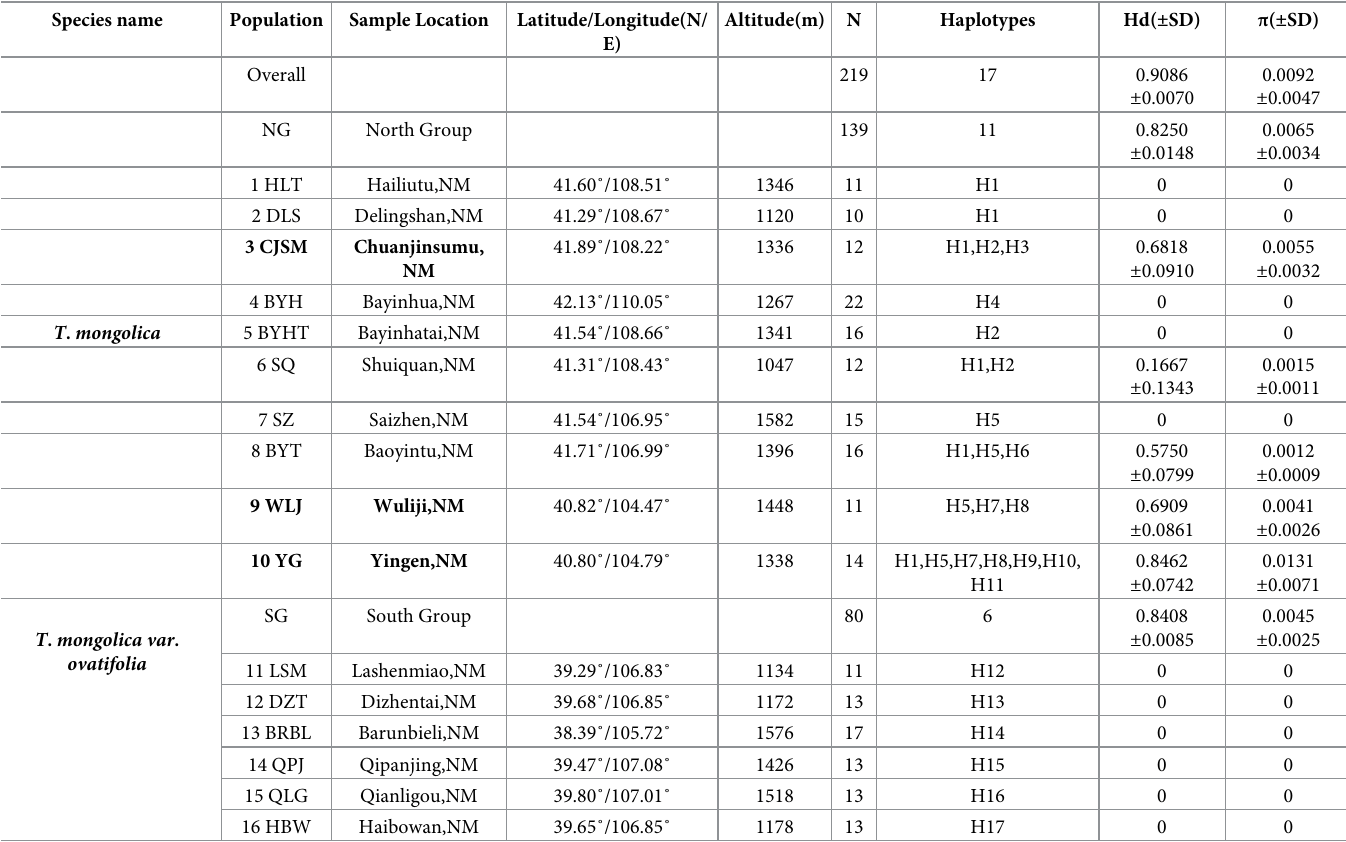
Table 1. Sample and genetic variation information for 16 populations of Tugarinovia mongolica in northwest